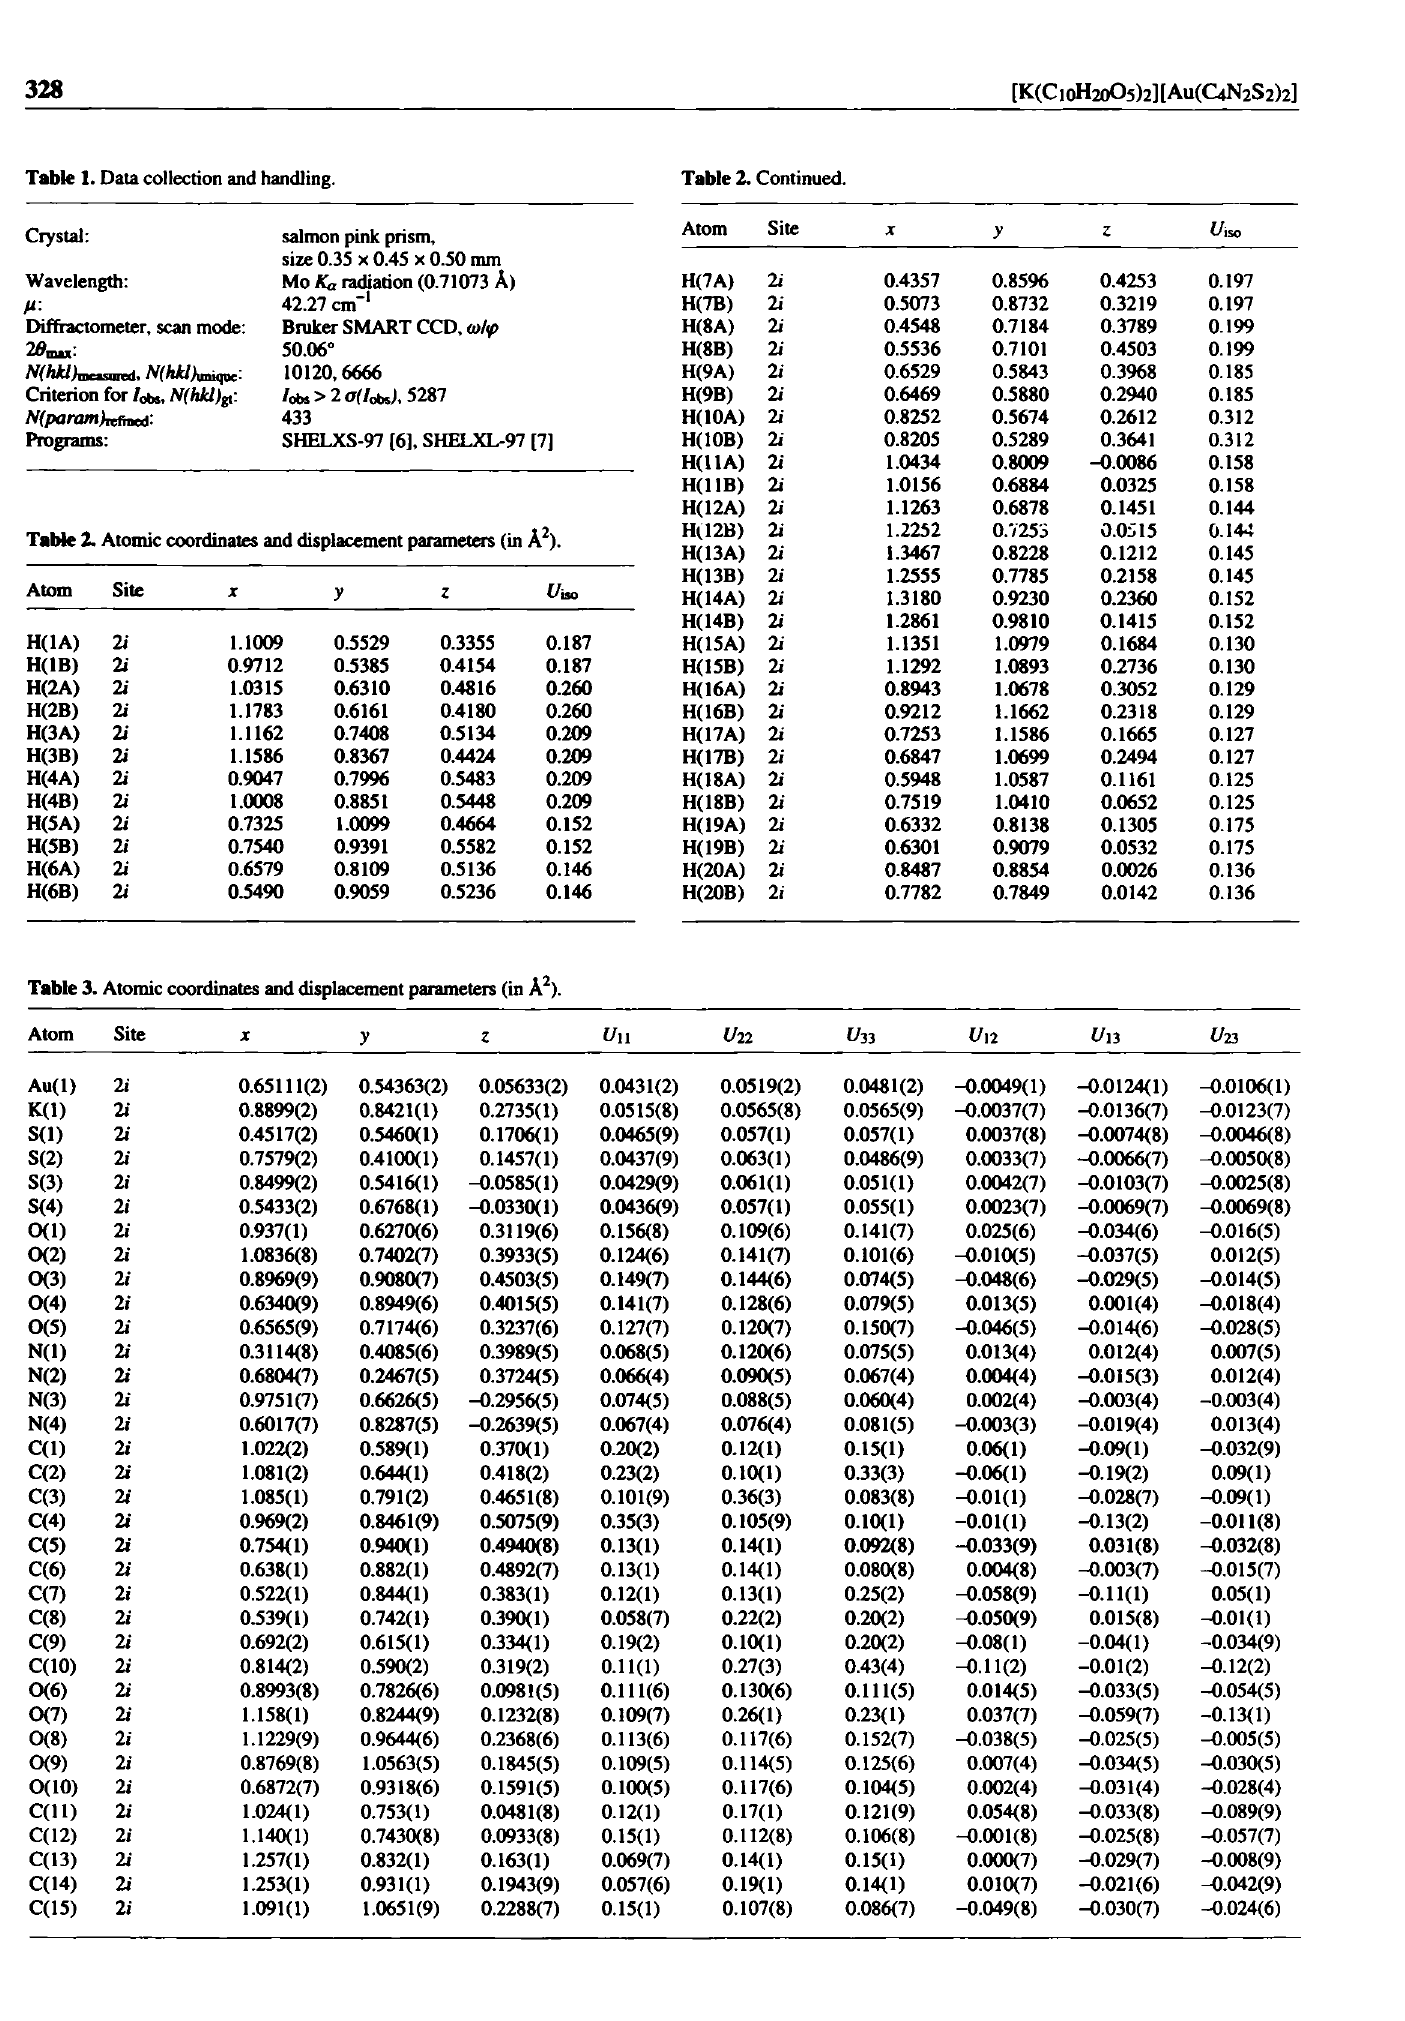
Table 2. Atomic coordinates and displacement parameters (in A 2 ).